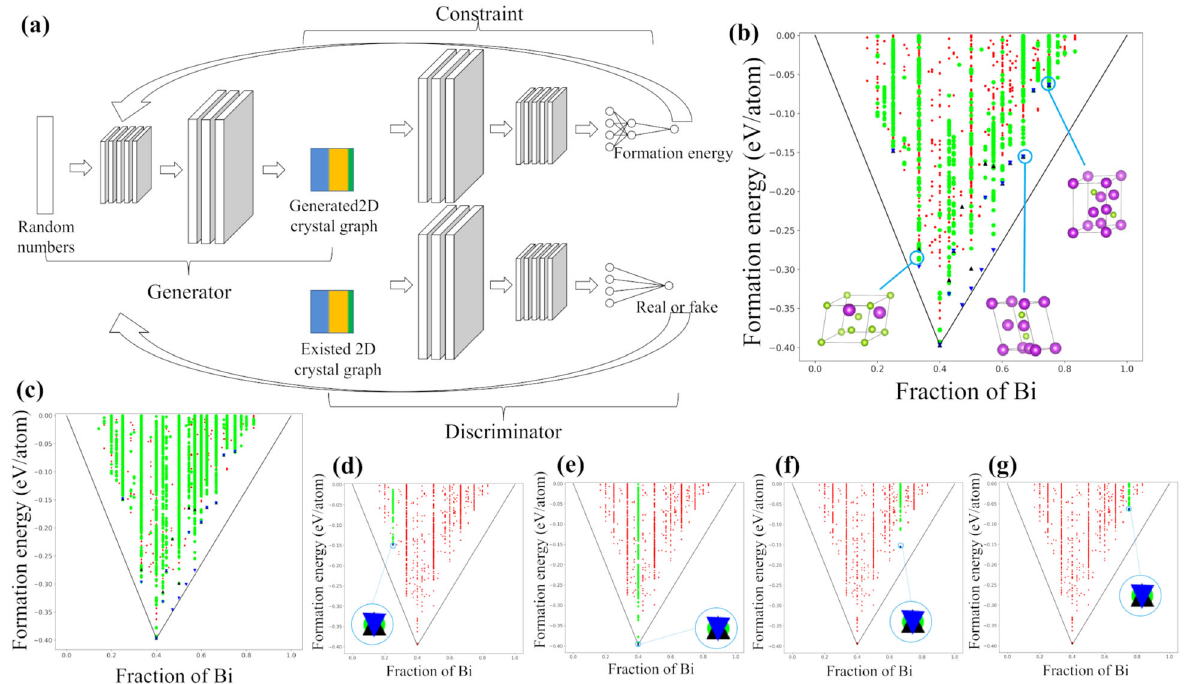
Fig. 3 Illustration on the CCDCGAN model. ( a ) Schematic diagram of the CCDCGAN model; ( b ) Scatter plot of formation energy vs. composition of CCDCGAN generated structures, where the black line represents the convex hull, red points denote the crystal structures considered in our machine learning database, green circles represent the generated structures, blue triangles indicate the experimentally achievable phases, black triangles are the crystal structures of the available Bi-Se phases in the Bi-Se database; and crystal structure of generated Bi 2 Se 4 , Bi 4 Se 2 , and Bi 6 Se 2 ; ( c ) Scatter plot of formation energy vs. composition of 100,000 structures generated by CCDCGAN; ( d ) The BiSe 3 phases regenerated by CCDCGAN, which are trained with the BiSe 3 composition removed; ( e ) The Bi 2 Se 3 phases regenerated by CCDCGAN, which are trained with the Bi 2 Se 3 composition removed; ( f ) The Bi 2 Se phases regenerated by CCDCGAN, which are trained with the Bi 2 Se composition removed; ( g ) The Bi 3 Se phases regenerated by CCDCGAN, which are trained with the Bi 3 Se composition